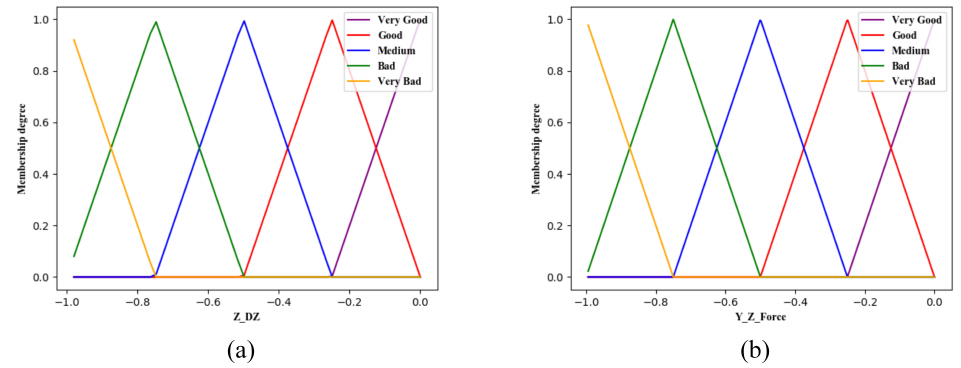
Figure 8. The second layer of membership function: ( a ) F y − F z membership function; ( b ) Z − D Z membership function .